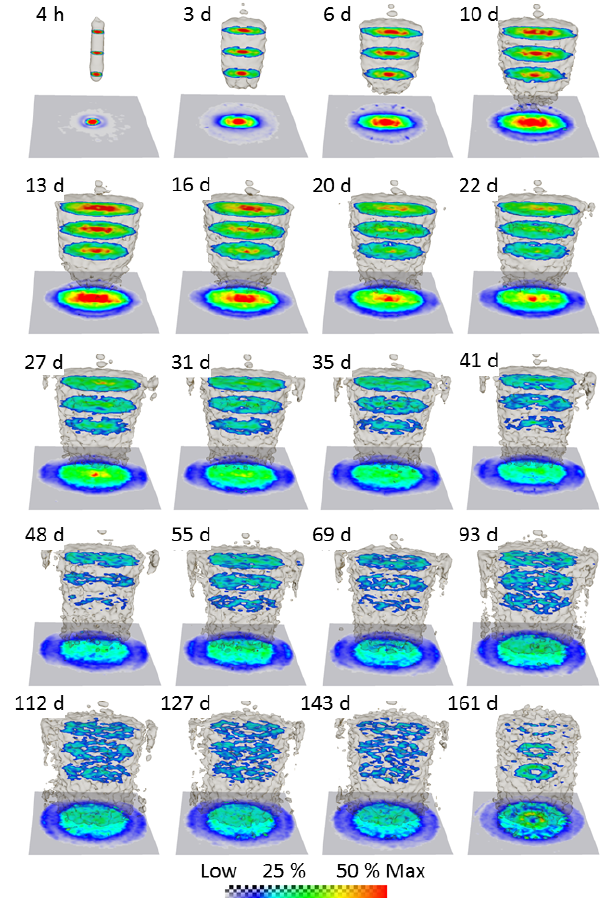
Figure 5. 20 PET frames of 22 Na diffusion in an OPA drill core (diameter: 100mm, length 80mm). Each frame is depicted as iso- surface of the one-tenth maximum value (grey), three horizontal slices through the source region, and the axial (vertical) maximum projection at the bottom. The colour ranges are scaled frame-wise; the maximum value of the colour range is half maximum total am- plitude (for the corresponding amplitude distribution, see Fig. 6).